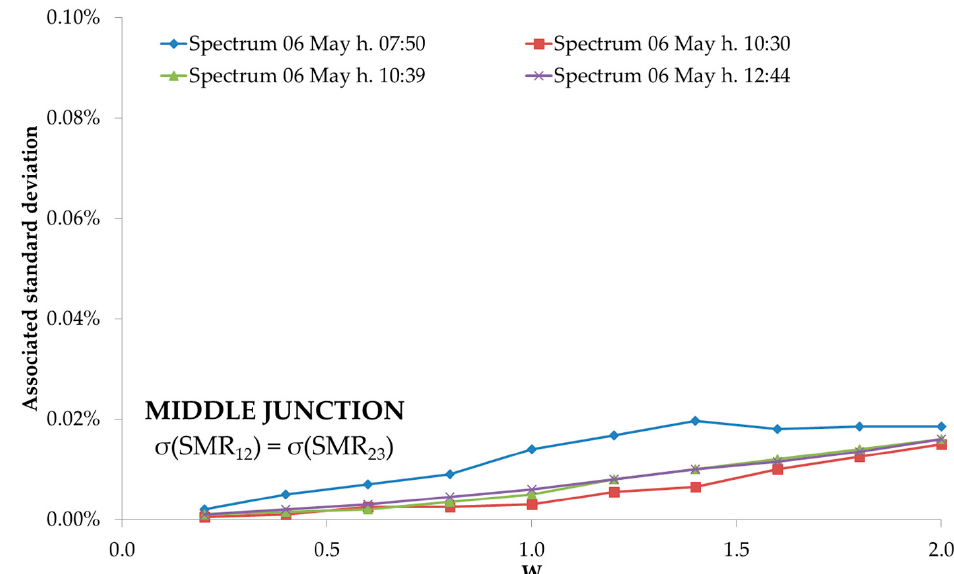
Figure 5. Impact of the errors on Middle junction spectral responsivity on SMR 12 and SMR 23 (k = 1). The slope of the functions indicates how much the output error is sensitive to an accurate estimation of the input errors on the middle junction spectral response.